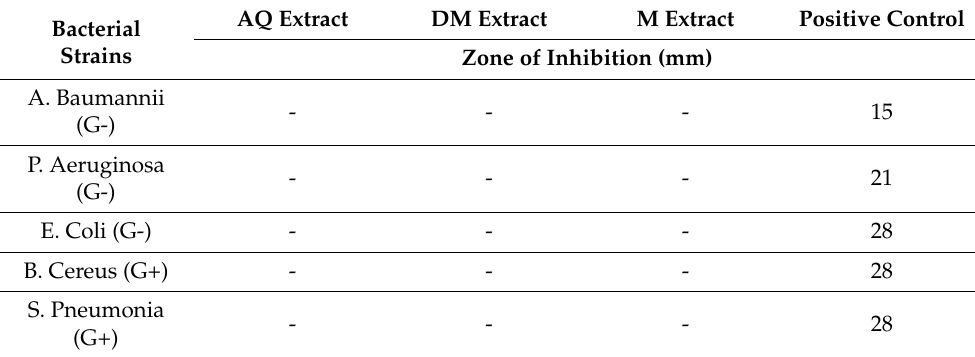
Table 4. Antibacterial effect of J. rubens extracts. Bacterial